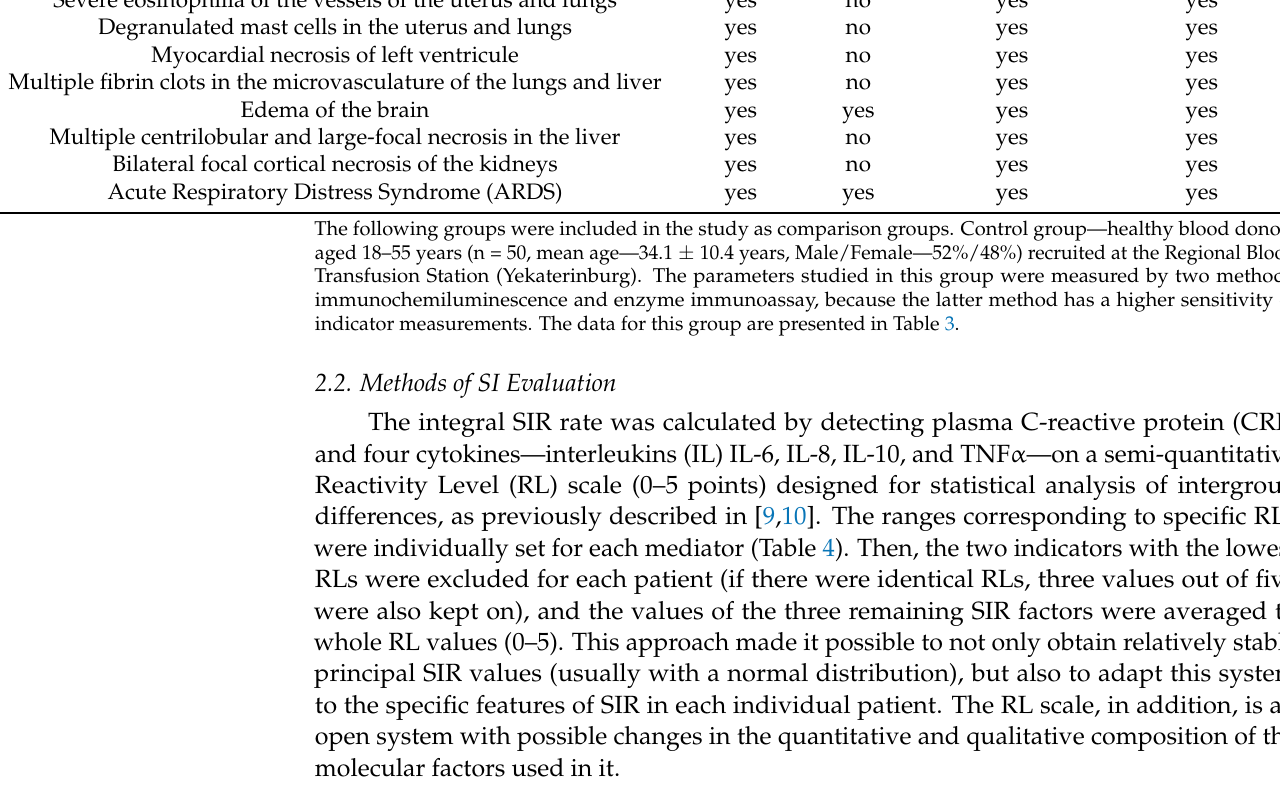
Table 3. Descriptive statistics of markers measured by enzyme immunoassay in the control group.